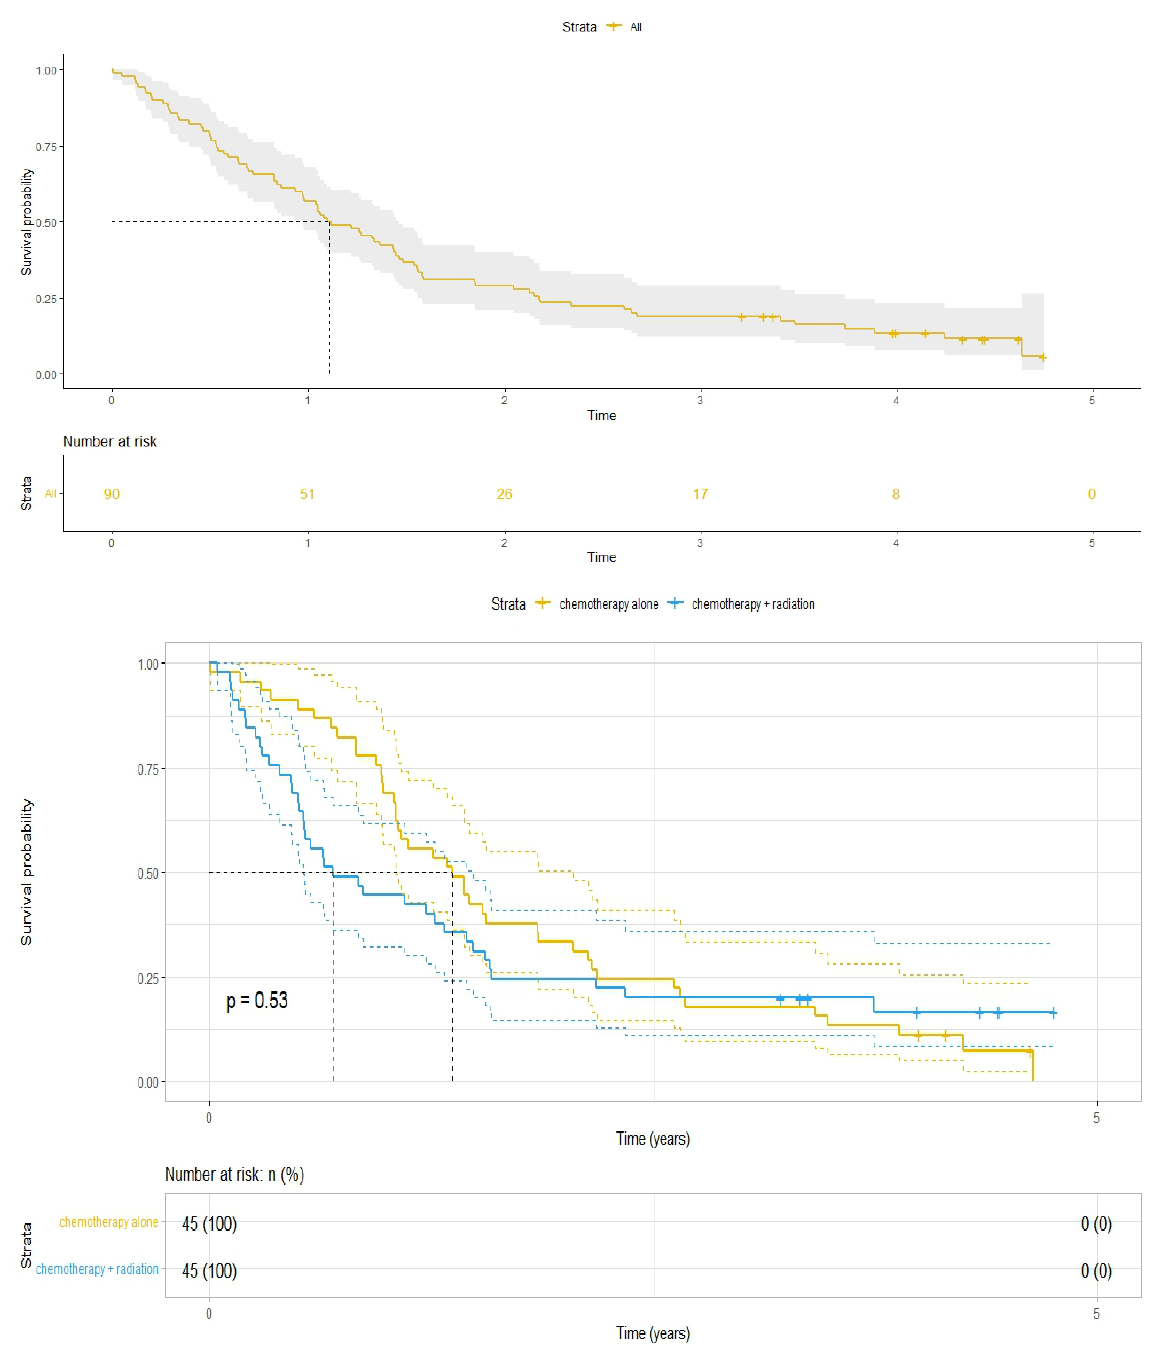
Figure 1. Illustrating the overall survival curve and the crossing survival curves for the two types of